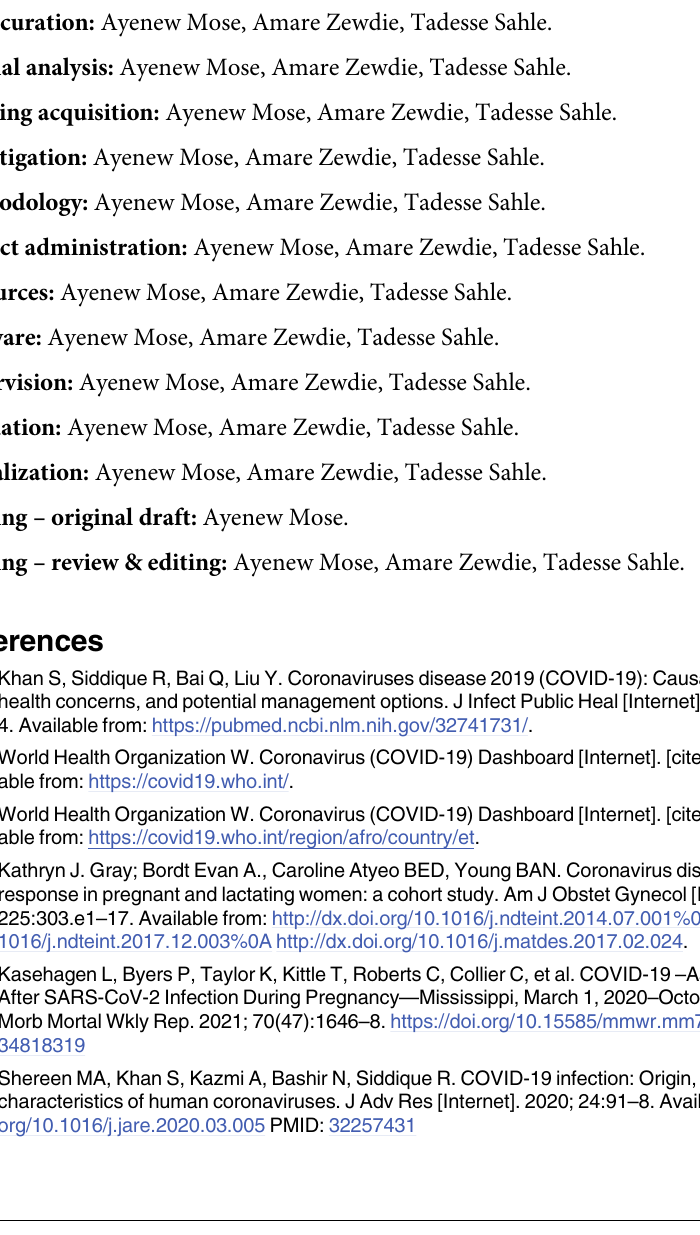
S2 Table. Search strategy for the databases. S3 Table. Newcastle-Ottawa quality assessment